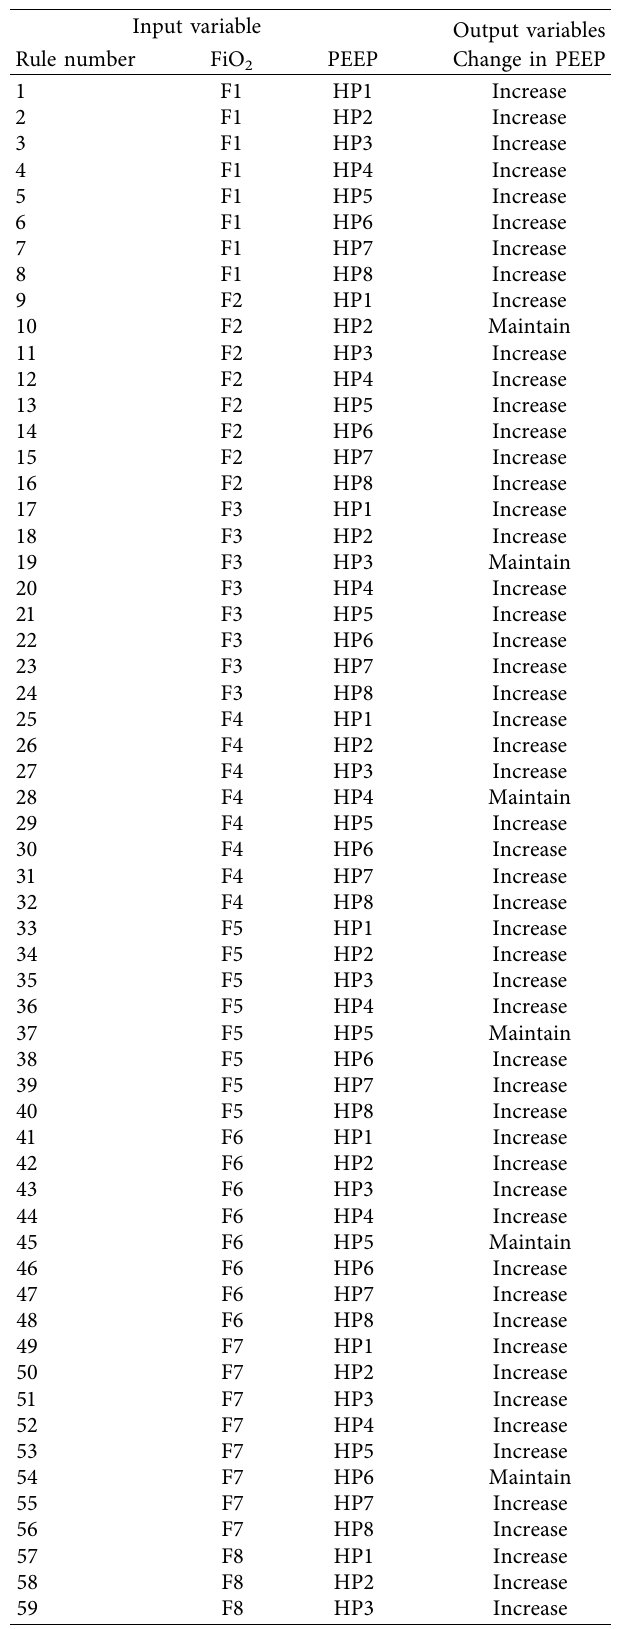
Table 7: FiO 2 and high PEEP fuzzy set